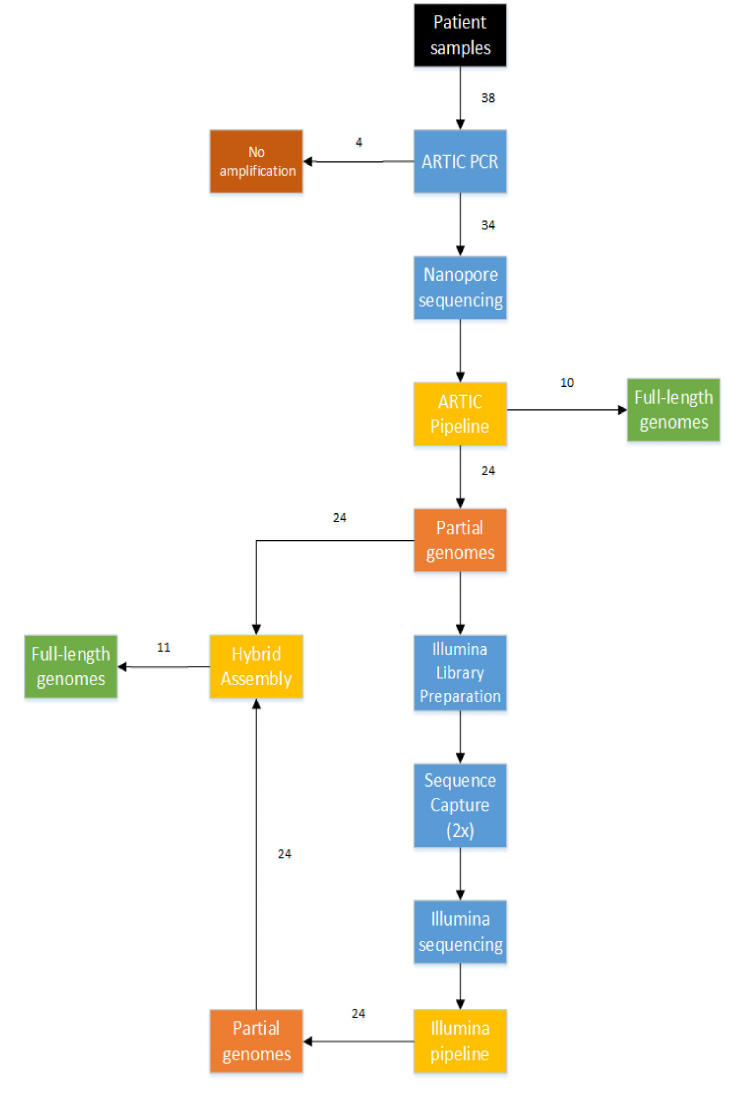
Figure 2. Workflow used to successfully sequence 21 out of 38 patient